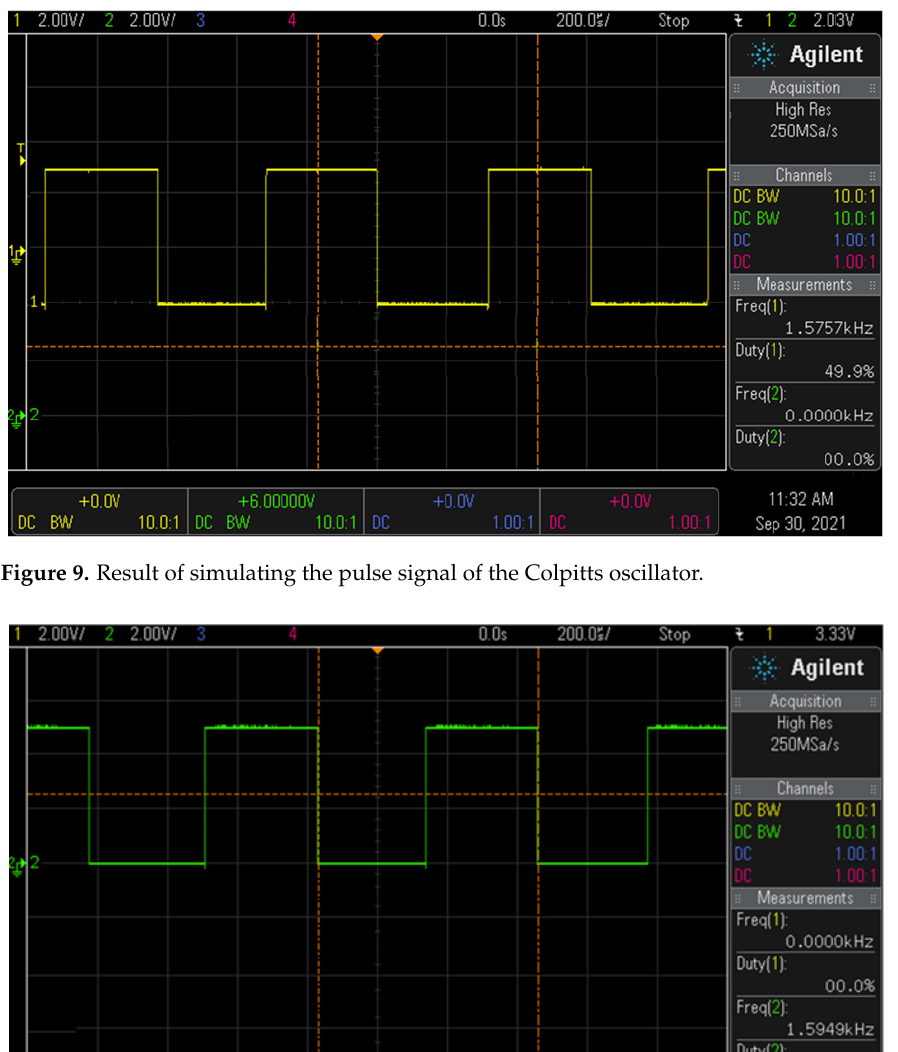
Figure 8. Result of simulating the oscillations of a Colpitts oscillator.